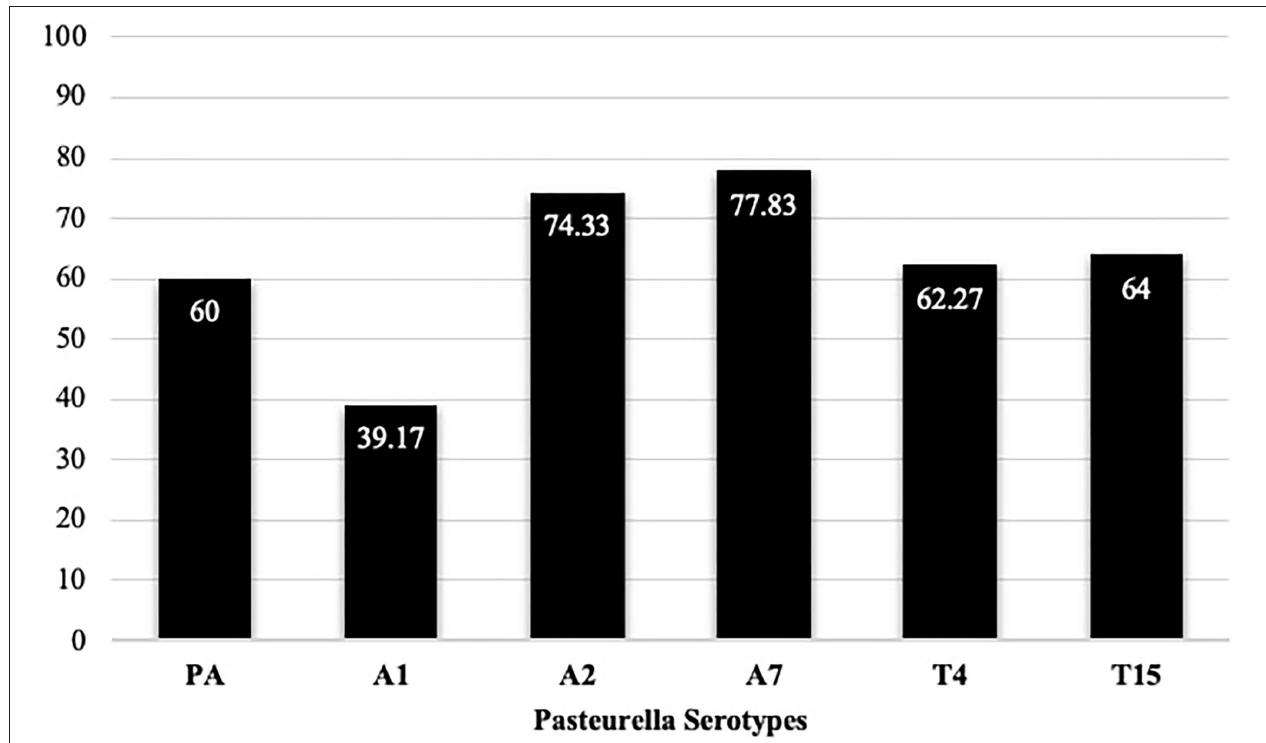
FIGURE 3 | Individual-level serotype prevalence, in which 600 serum samples were collected from the study areas and each sample was subjected to IHA testing against six (6) serotypes. PA = P. multocida biotype A. Percentage of positive samples out of 600 is provided.